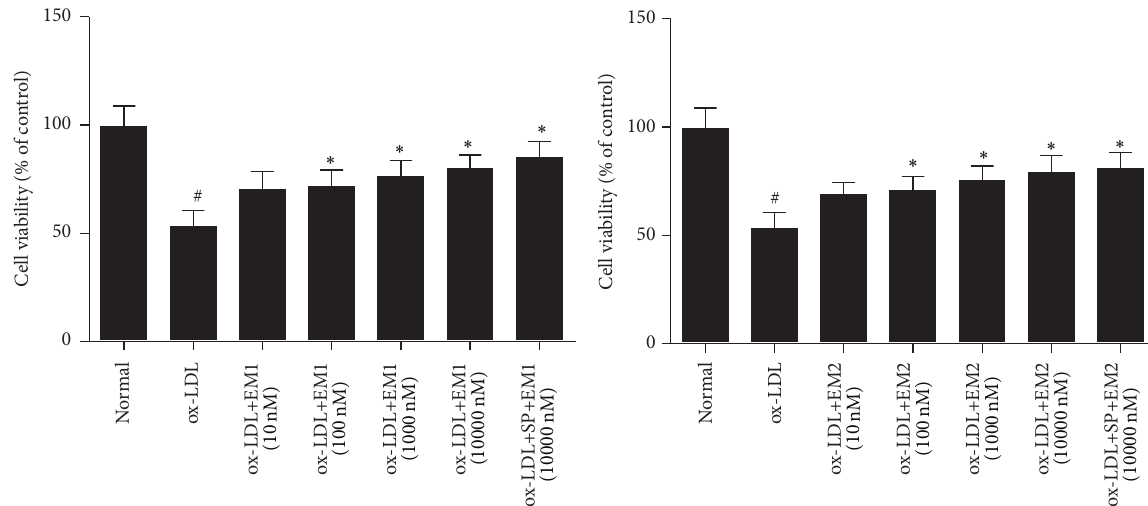
Figure 1: Effect of EM1/EM2 on cell viability of HUVECs treated by ox-LDL. Cell viability was determined by MTT test. All data is expressed as mean ± SD. ∗ 𝑃 < 0.05 versus control. # 𝑃 < 0.05 versus ox-LDL.